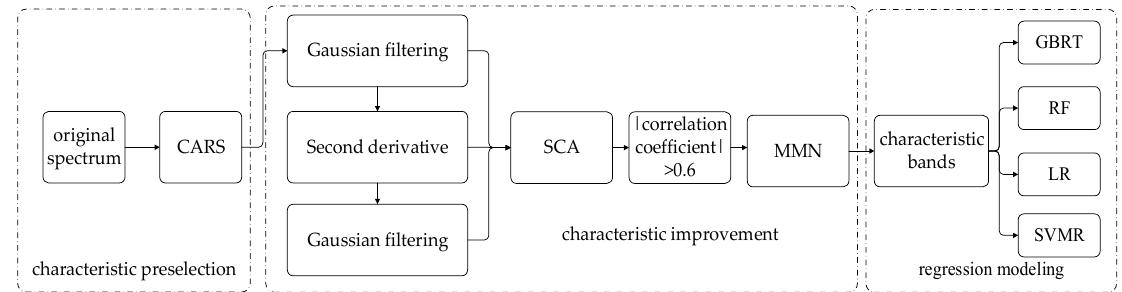
Figure 2. Characteristic band selection algorithm flowchart.